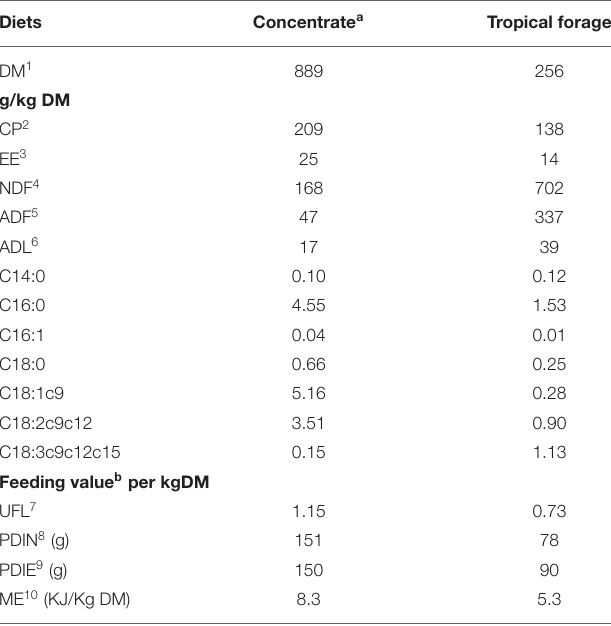
TABLE 1 | Chemical composition of experimental diets (g/kg